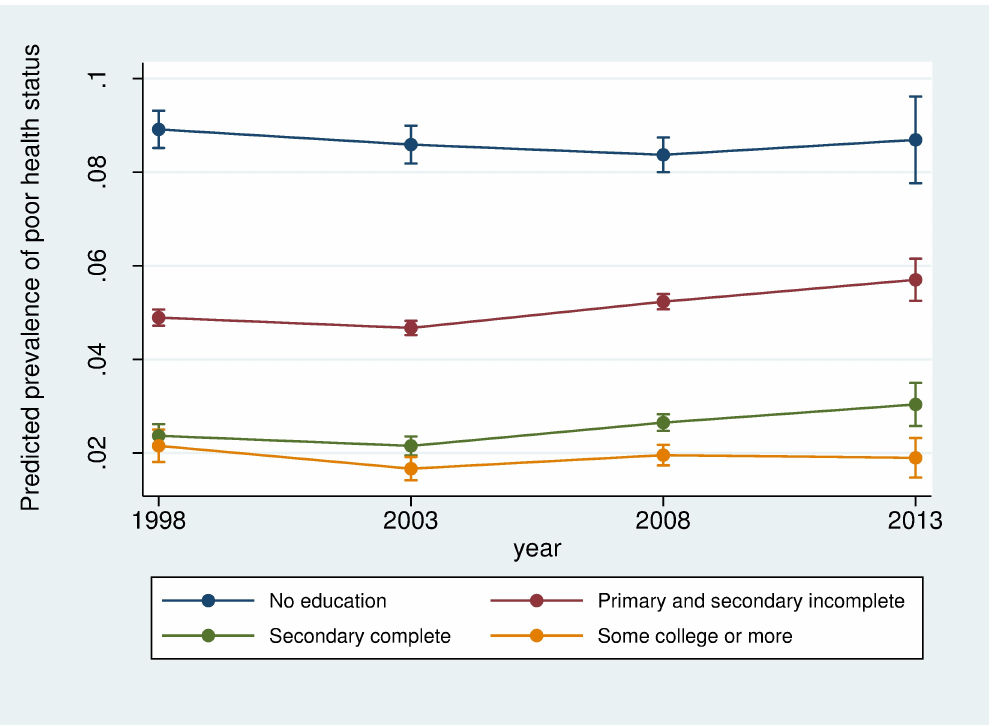
Fig 1. Predicted prevalence rates of poor health in Brazil by educational levels: 1998–2013.